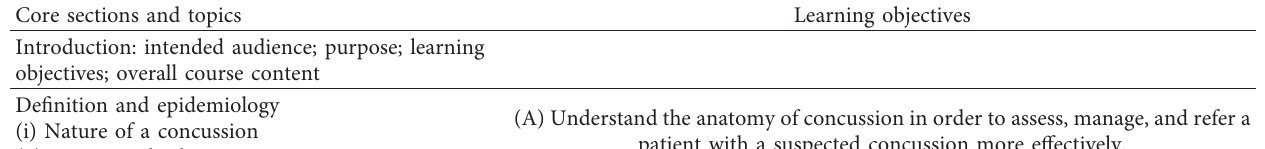
Table 1: Content overview of the CATT for medical professionals, self-assessments